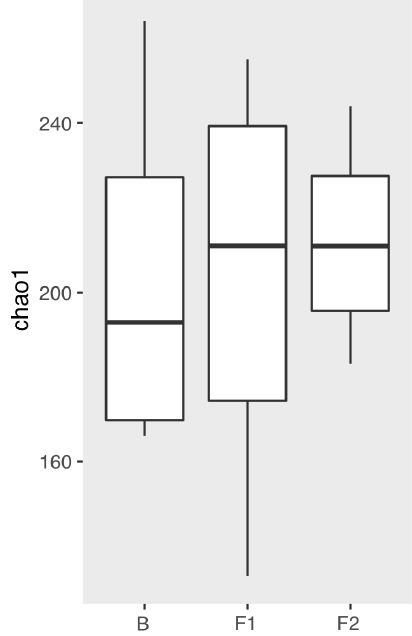
Figure 2. Chao1 diversity of the pooled saliva samples.